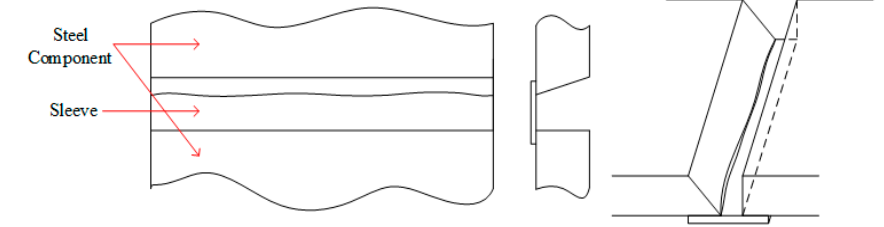
Figure 3. Non-standard grooves (non-uniform variation of bottom clearance in a small range).